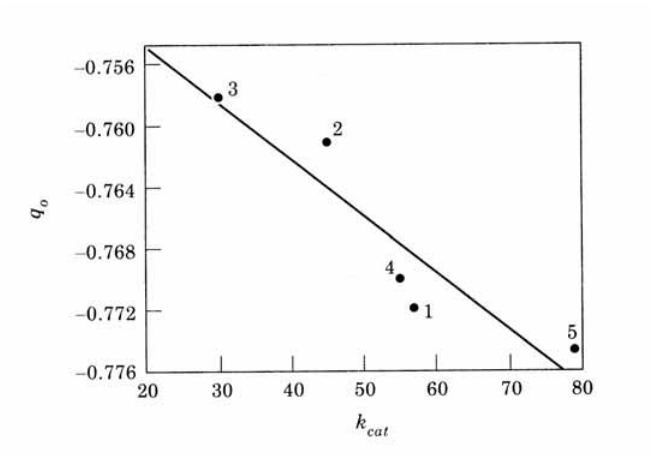
vs. experimental k 0